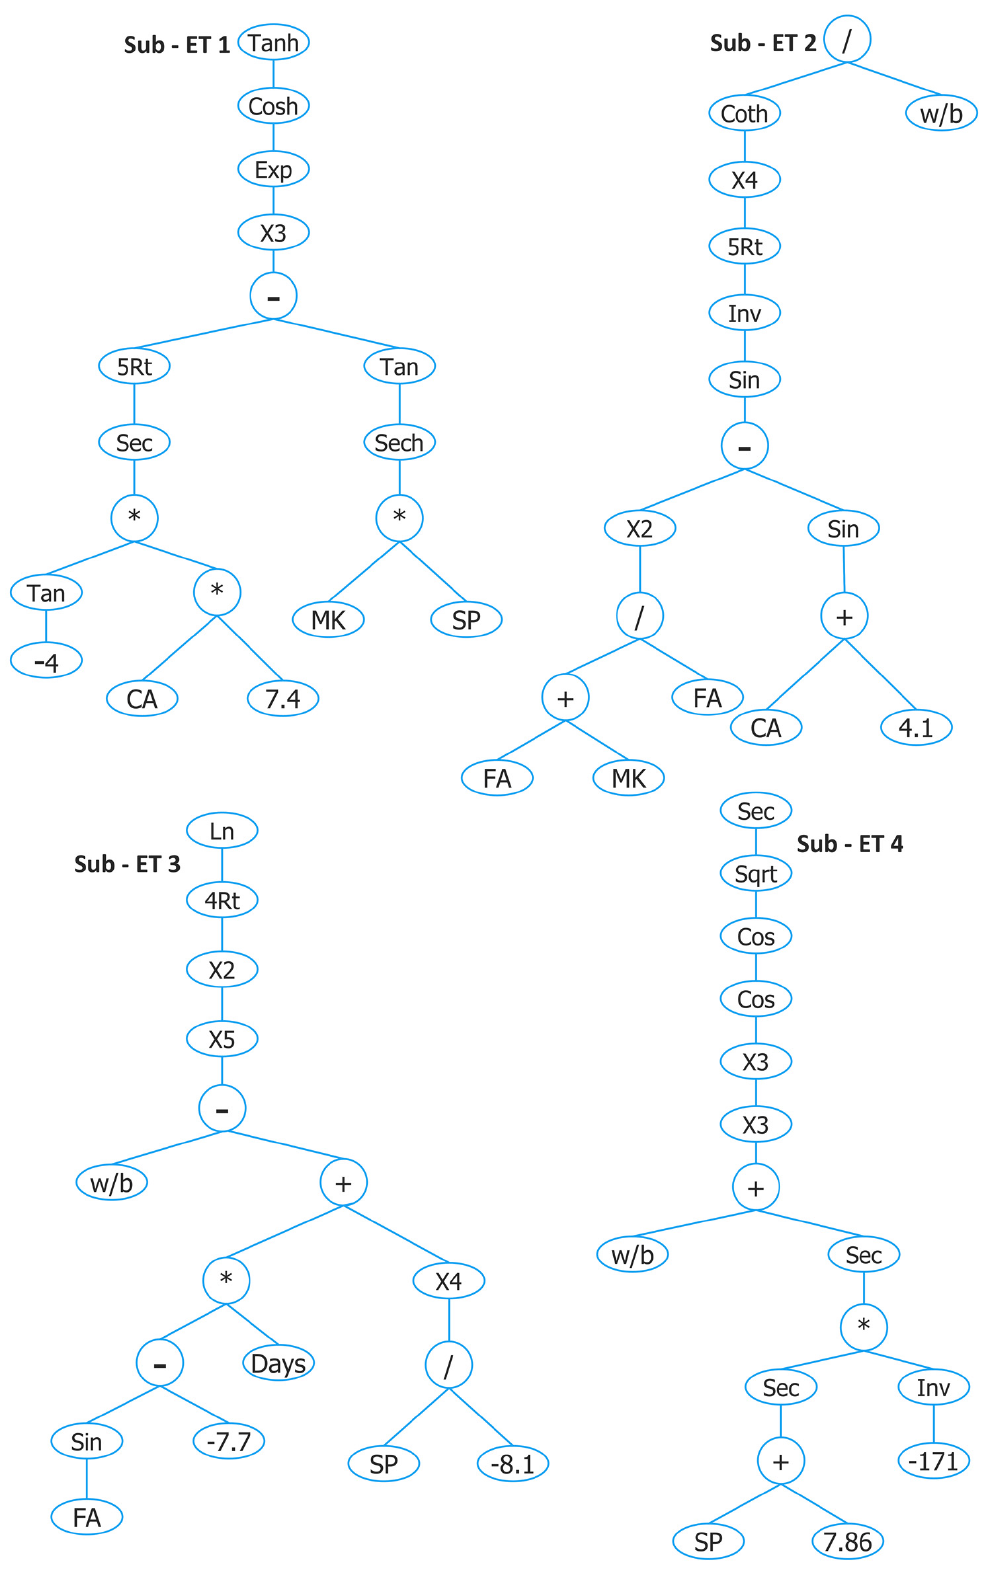
Figure 6. Expression tree of GEP I developed for predicting (cid:1858)′ (cid:2913) of concrete with MK.